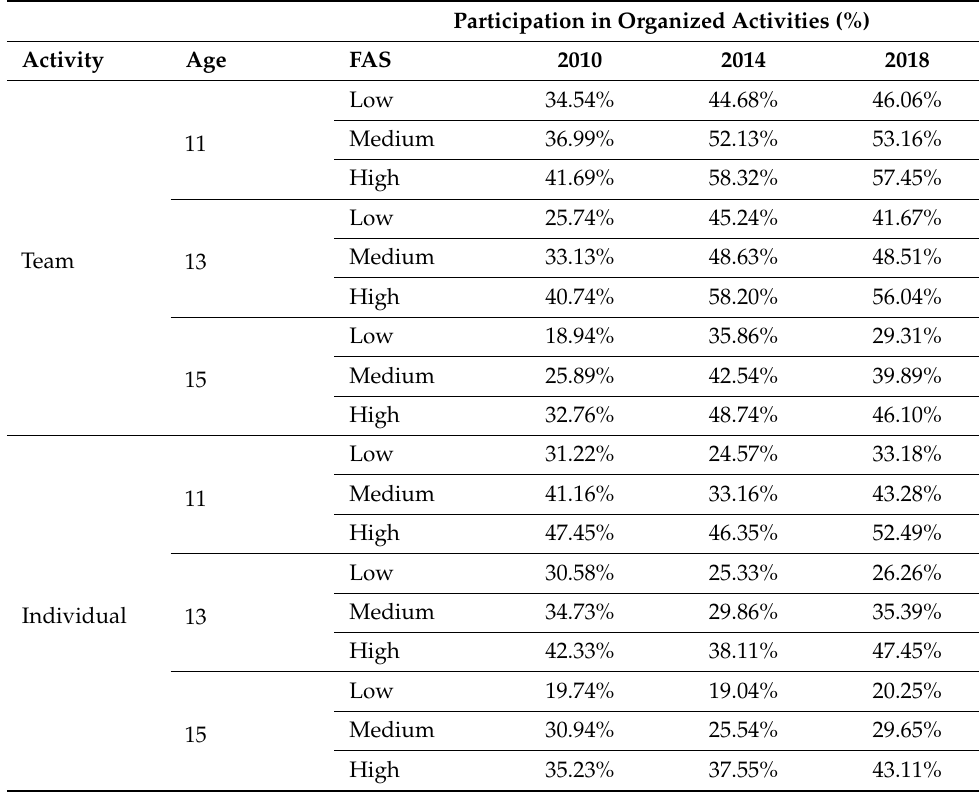
Table 1. Description of the study population: rates of respondents’ involvement in organized team and individual sport activities for data collected in 2010, 2014 and 2018, Health Behaviour in School- Aged Children study (HBSC) in the Czech Republic.